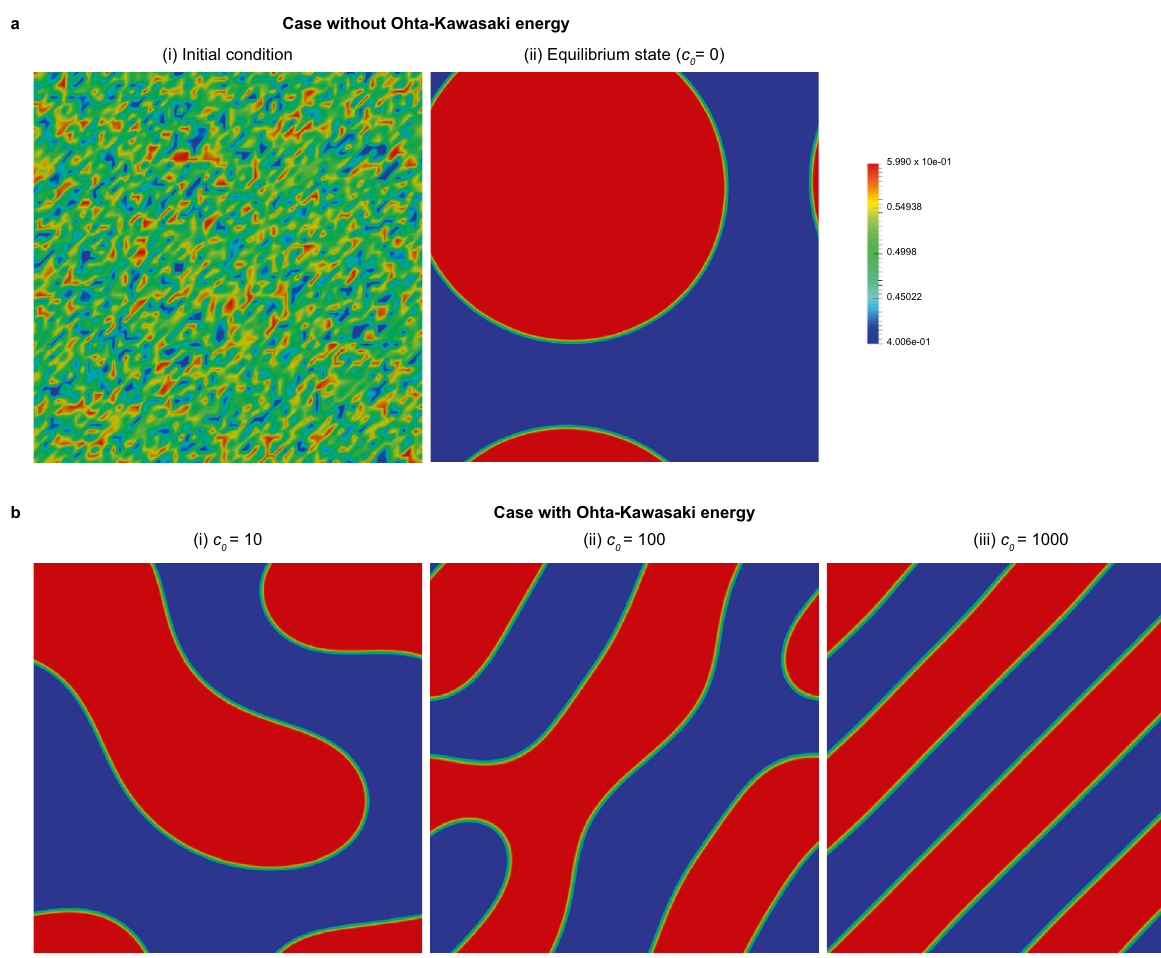
Figure 2. ( a ) Results of the phase-field analysis without considering the Ohta-Kawasaki energy at the (i) initial state and (ii) equilibrium state. A cubic or two-dimensional hexagonal structure is observed at the (ii) equilibrium state. ( b ) Parametric study of the phase-field analysis with the change in strength of the Ohta-Kawasaki energy. The stronger the Ohta-Kawasaki energy becomes, the finer the microstructure at the equilibrium